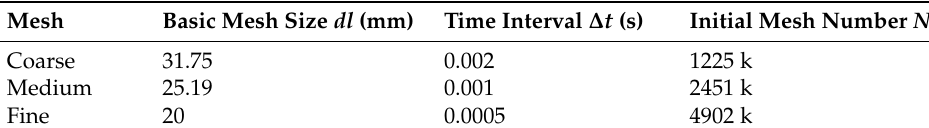
Table 2. Detailed information on the initial mesh systems.